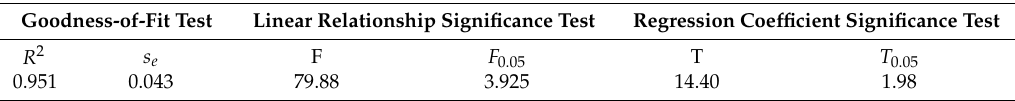
Table 4. Statistical test results of regression equation.